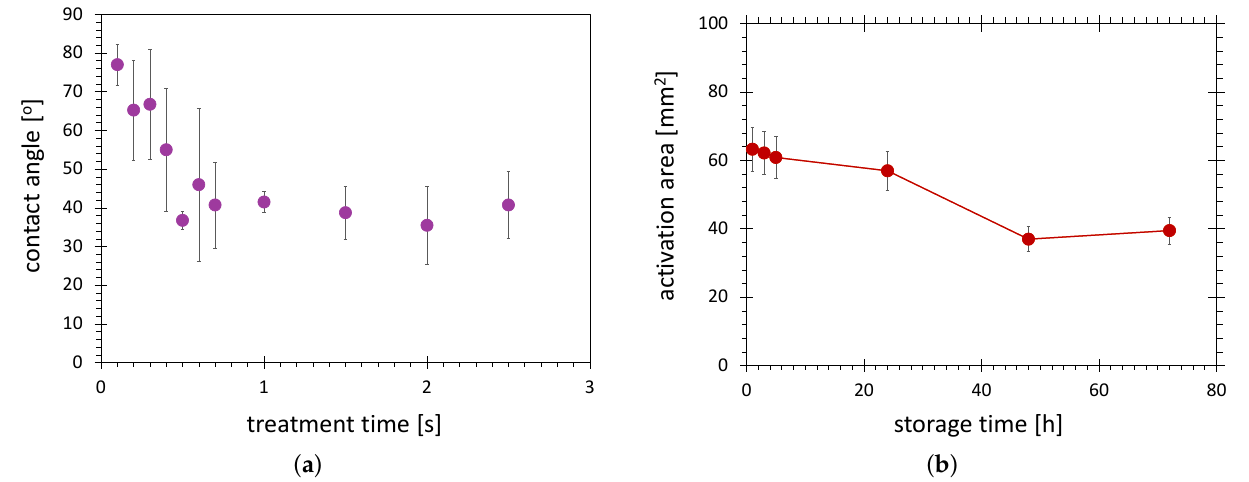
Figure 16. ( a ) the contact angle of water on titanium surface as a function of the treatment time and ( b ) the activation area visualized by use of 72 mJ/m 2 test ink on a titanium surface as a function of storage time after 10 s treatment. The plasma treatment is conducted with piezobrush ® PZ3 with a near-field module at a distance of 1 mm from the titanium plate. The treatment and storage were in ambient air (temperature of 20 ◦ C, relative humidity of 50%).